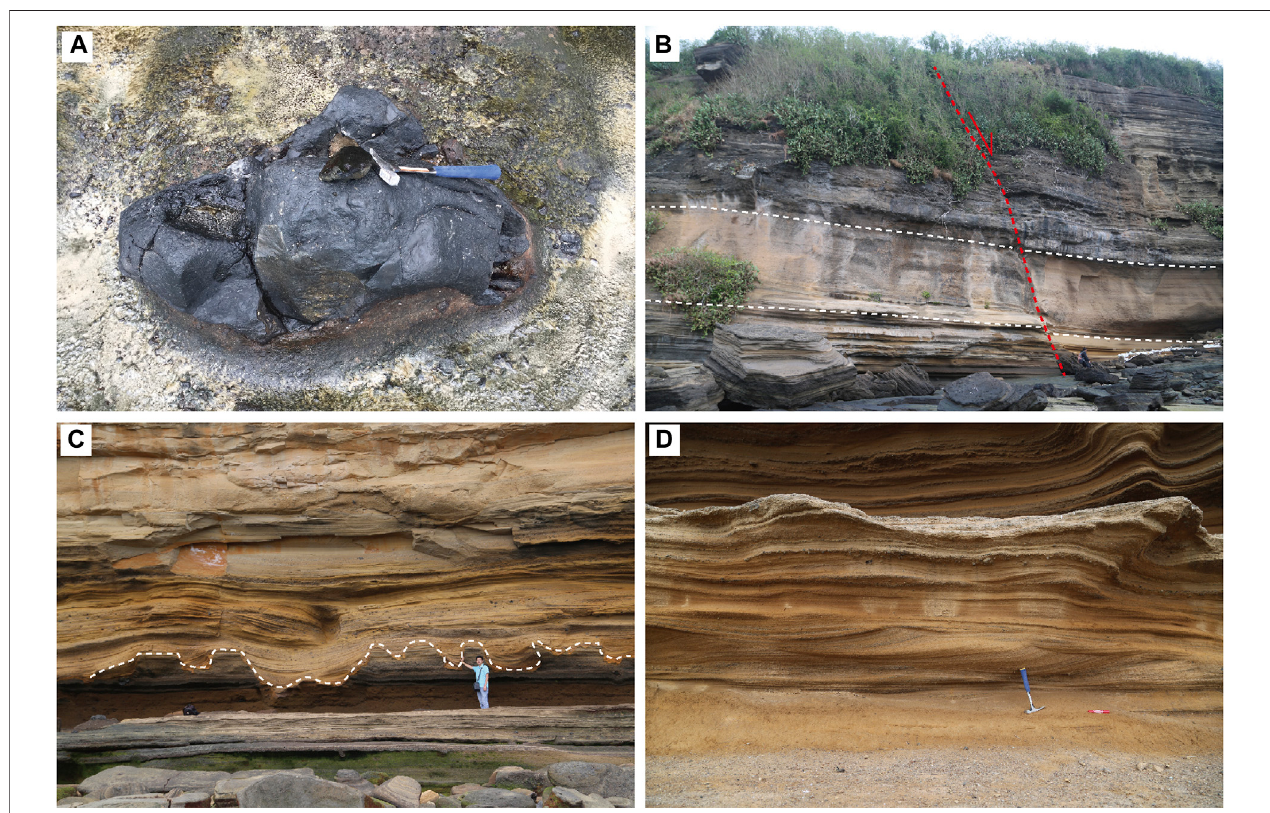
FIGURE 4 | Field photographs of Daling volcano deposits. (A) Indurated agglomerates with a baking layer. (B) An approximately 30 m-thick pro fi le of Shiluokou, withPDCsdepositsonthetopandbottomofthepro fi leandtephra-fallpyroclasticsinbetween.Thesestrataareseparatedbyanormalfault. (C) U-shaped grooves. (D) Cross and oblique beddings in the PDCs